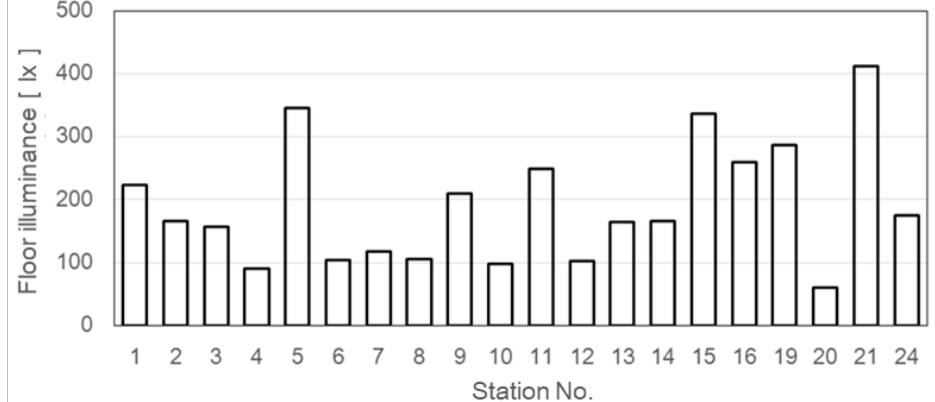
Figure 8. Floor illuminance measurement result at the middle landing.